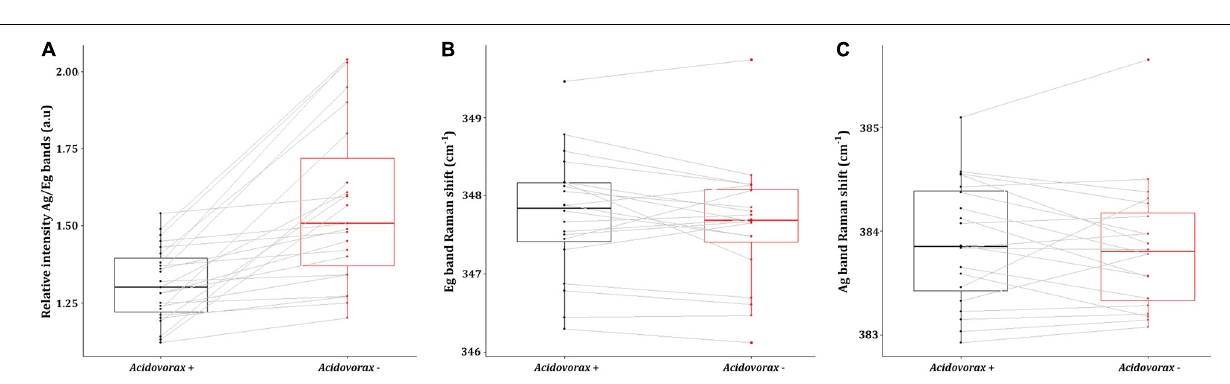
FIGURE 7 | Average values of the intensity ratio of the Ag band relative to Eg band (A) , the Eg band Raman shift (B) and the Ag band Raman shift (C) of pyrite Raman spectra in presence (red) or absence (black) of Acidovorax resulting from Raman analysis of the IPB subsurface native